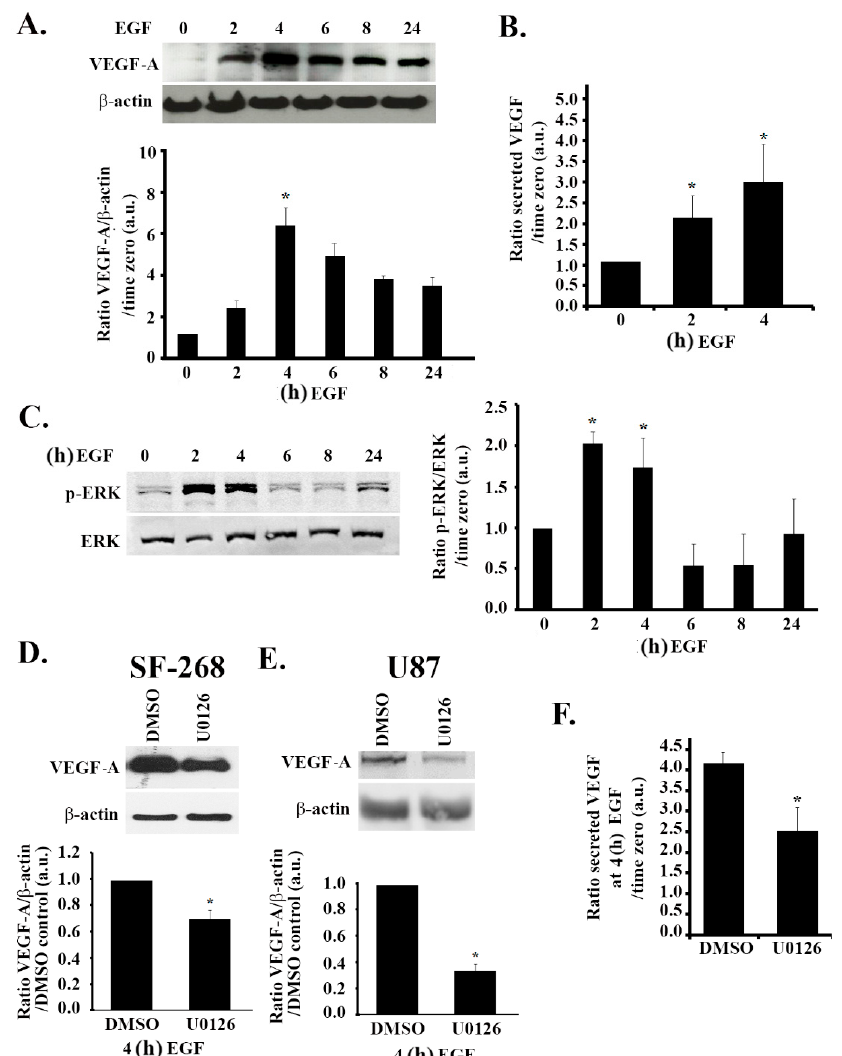
Figure 4. EGF-induced increase in VEGF expression and secretion is ERK-dependent. (A / C) SF-268 cells were starved in serum-free media for 3 h, then stimulated with 15 nM EGF for the indicated times. Cells were then lysed, and the lysates were blotted for VEGF-A and β -actin ( A ) or p-ERK and ERK ( C ). The graphs in each panel are densitometric analysis of the Western blots using Image J. Values are normalized to the loading control ( β -actin and ERK for VEGF and p-ERK, respectively) and expressed as fold change compared to time zero ( − EGF). ( B ) ELISA for supernatants from SF-268 cells treated with EGF for 2 or 4 h or left untreated and measured for VEGF-A secretion according to the manufacturer’s guidelines. Values are expressed as fold change compared to time zero. ( D ) SF-268 cells were treated with 50 µ M U0126 for 24 h (with DMSO as carrier). Cells were then treated with 15 nM EGF for 4 h and lysed, and cell lysates were blotted for VEGF-A or β -actin for loading control. The graphs are quantitations of the VEGF bands normalized to actin and expressed as fold change compared to control (DMSO). E) U87 cells were treated with 50 µ M U0126 for 24 h (with DMSO as a carrier). Cells were then treated with 15 nM EGF for 4 h and lysed, and cell lysates were blotted for VEGF-A or β -actin for loading control. The graphs are quantitations of the VEGF bands normalized to actin and expressed as fold change compared to control (DMSO). ( F ) Supernatants from SF-268 cells treated with U0126 or DMSO alone and then treated with EGF for 4 h (after 3 h starvation) were collected and measured for VEGF-A secretion according to the manufacturer’s guidelines. Values are expressed as fold change at every treatment to time zero ( − EGF). The data are means ± SEM from three di ff erent experiments; * p < 0.05 indicates statistically significant di ff